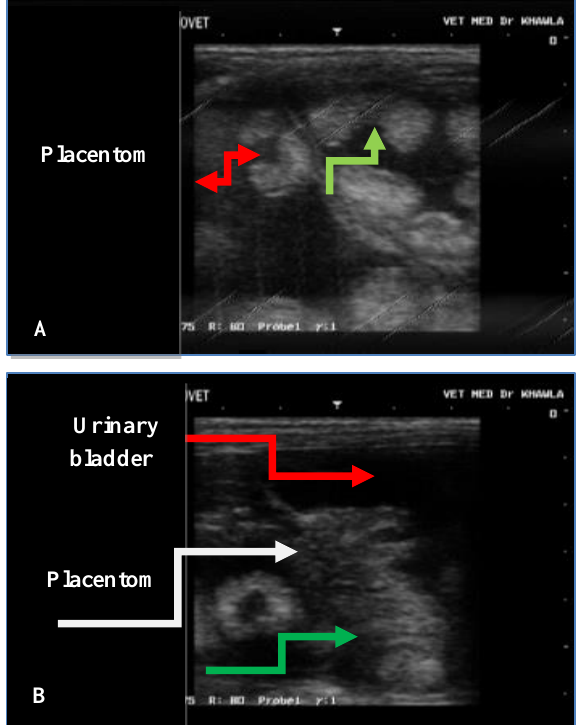
Figure, 2: Placentom size at days 40 of pregnancy in Shami goats. (early stage).